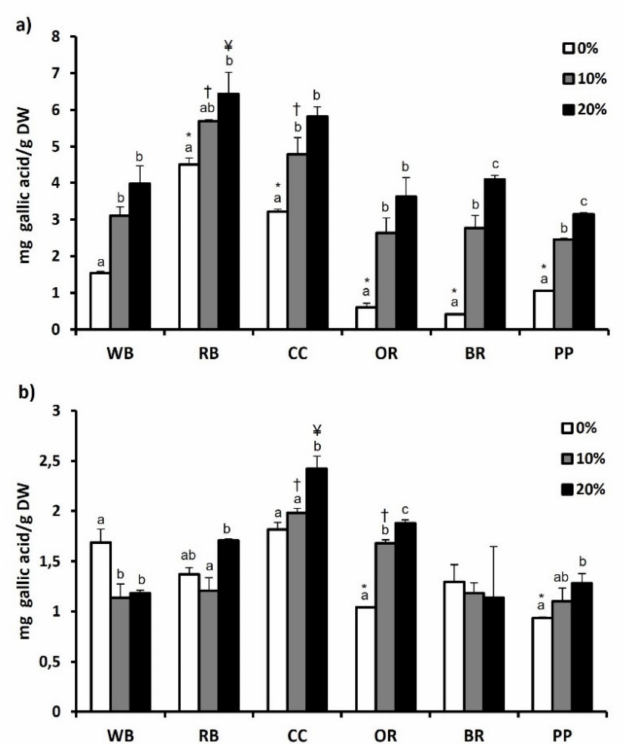
Figure 1. Total phenolic content of ( a ) agri-food substrates and ( b ) Tenebrio molitor larvae reared on the respective substrates (WB, Wheat bran; RB, Rice bran; CC, Corn cob; OR, Olive oil residues; BR, Biogas residues; PP, Potato peel). Different bar colors depict supplementation percentage of post-distillation residues of medicinal and aromatic plants (MAPs) in the substrates. Bars represent mean values of three replicates ± SE. Different letters depict significant differences regarding MAPs post-distillation residues supplementation in each substrate, while different symbols are used (*, †, ¥) to denote significant differences between substrates compared to the WB in the respective supplementation percentage of MAPs post-distillation residues (0%, 10%, 20%,